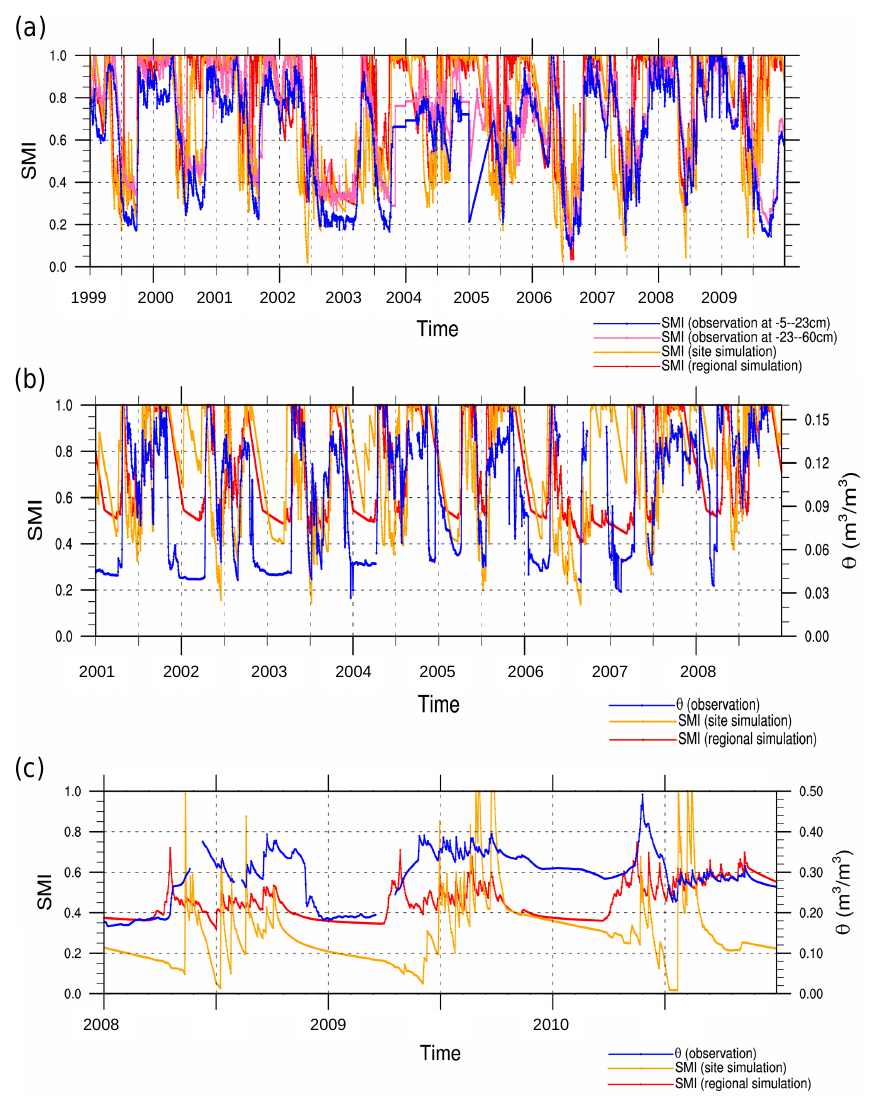
Figure 2. Soil moisture dynamics at the three micrometeorological sites: (a) Hyytiälä, (b) Sodankylä and (c) Kenttärova, comparing re- sults from regional (the model grid boxs where the sites are located) and site JSBACH simulations with observations. The volumetric soil moisture ( θ ) is shown for the Sodankylä and Kenttärova